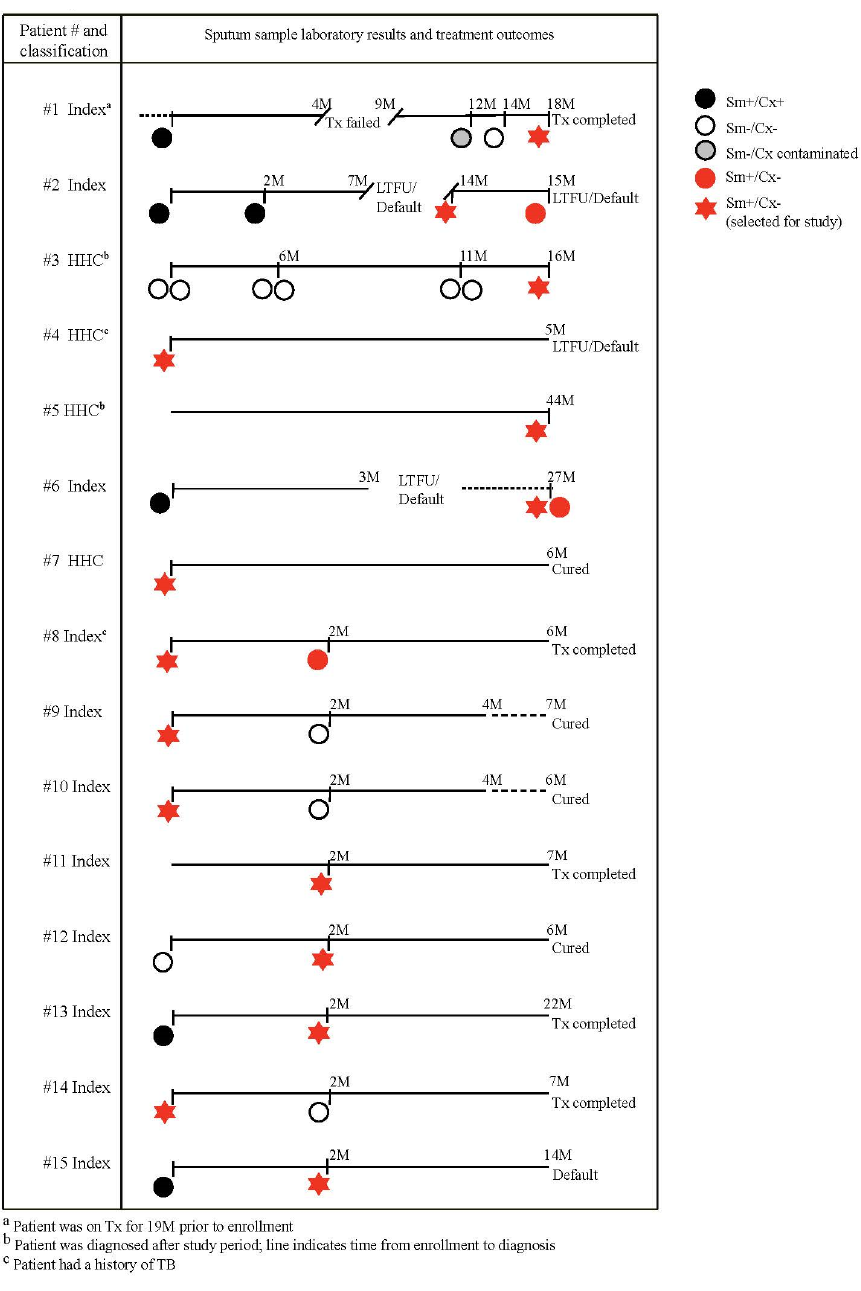
Figure 1. Timelines with sputum sample results and treatment outcomes for the 15 TB patients whose samples were selected.